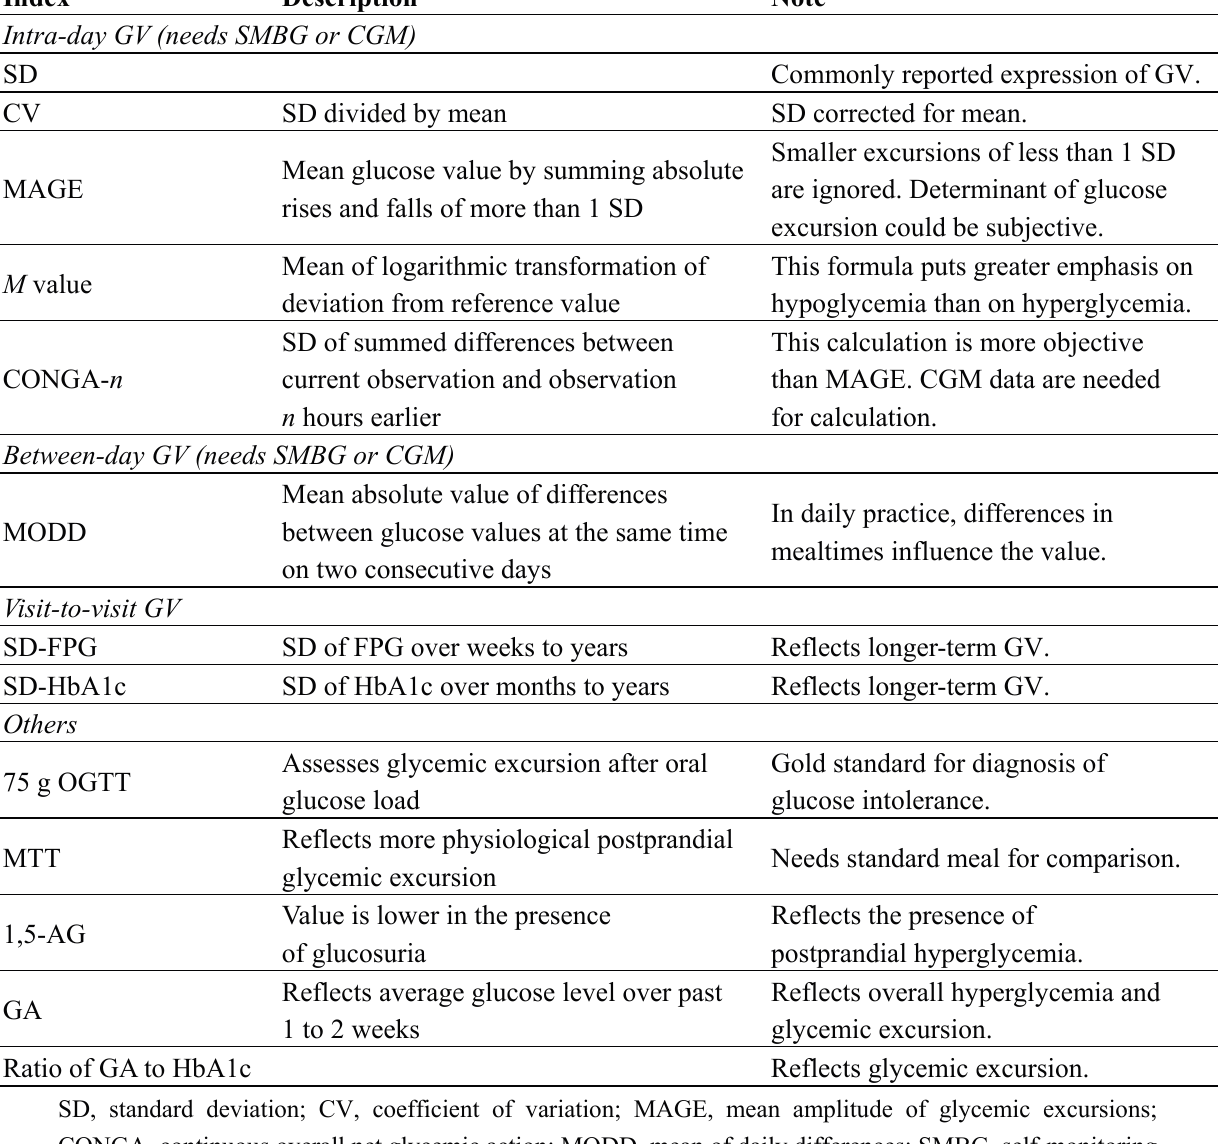
Table 1. Indices of glycemic variability